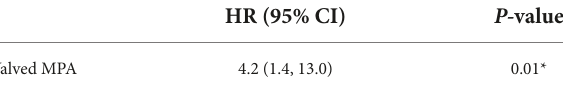
TABLE 6 Multivariable Cox proportional hazard modeling for risk factors of RVOT-related reinterventions.